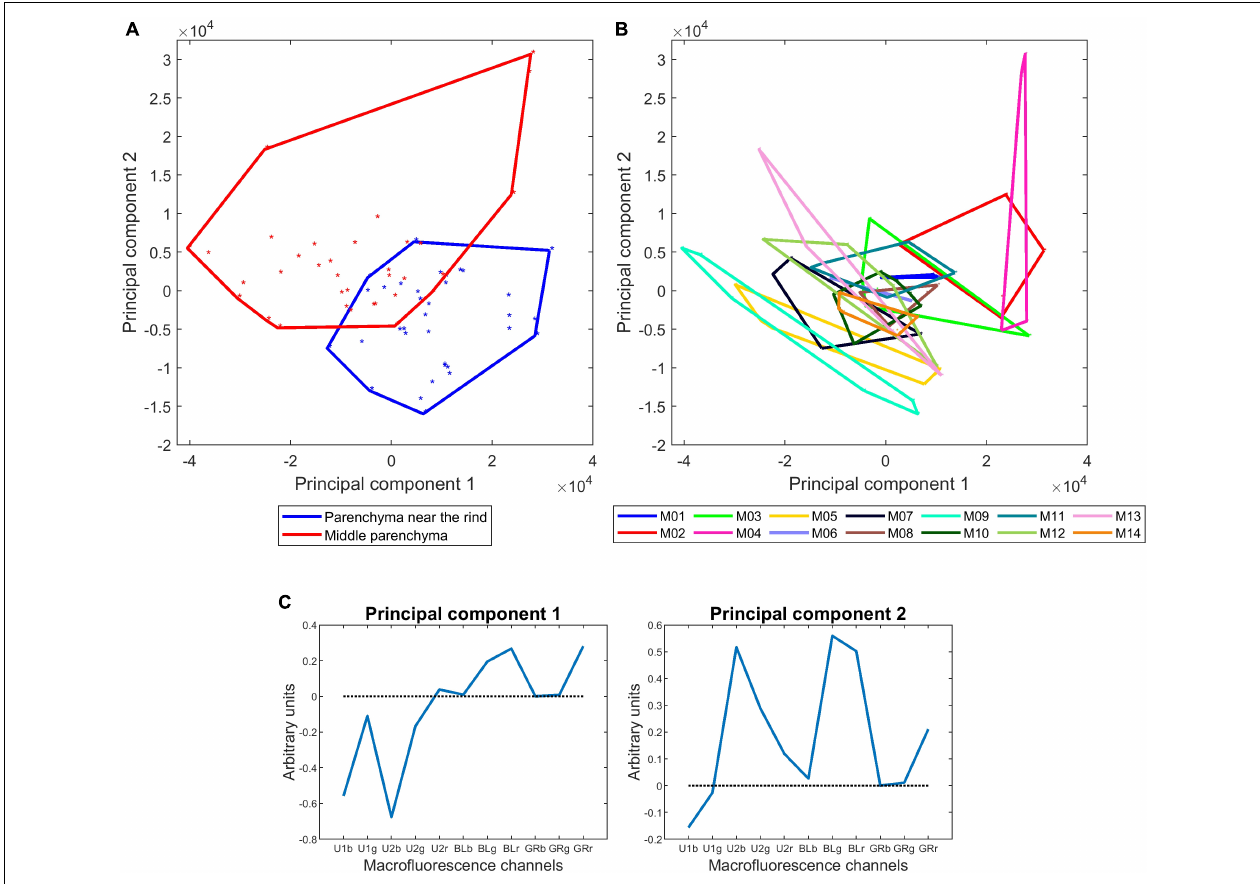
FIGURE 10 | Macrofluorescence analysis of the parenchyma tissues of 14 inbred lines: principal component analysis. (A,B) Sample similarity maps of components 1–2 (71 and 18% of the total variance) according to tissues and inbred lines. (C) Loadings 1 and 2. The similarity maps reveal the significant variabilities between inbred lines and between parenchyma near the rind and middle